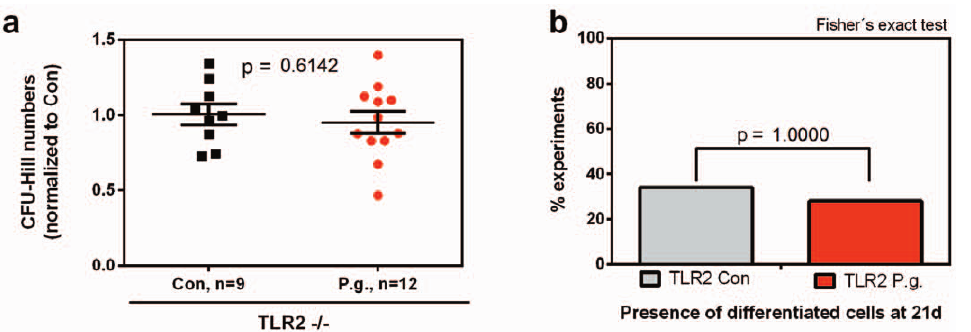
Figure 8. CFU-Hill and late-outgrowth mobilization is TLR2-dependent. No significant differences in CFU-Hill numbers (a) and the proportion of presence of differentiated late-outgrowth EPC (b) in P. gingivalis infected TLR2-deficient mice. Data are presented as mean colony counts 6 SEM relative to controls (CFU-Hill) or as numbers of experiments yielding differentiated colonies (late EPC). Data were analyzed using unpaired t-tests (CFU-Hill) or Fishers exact test (late EPC).